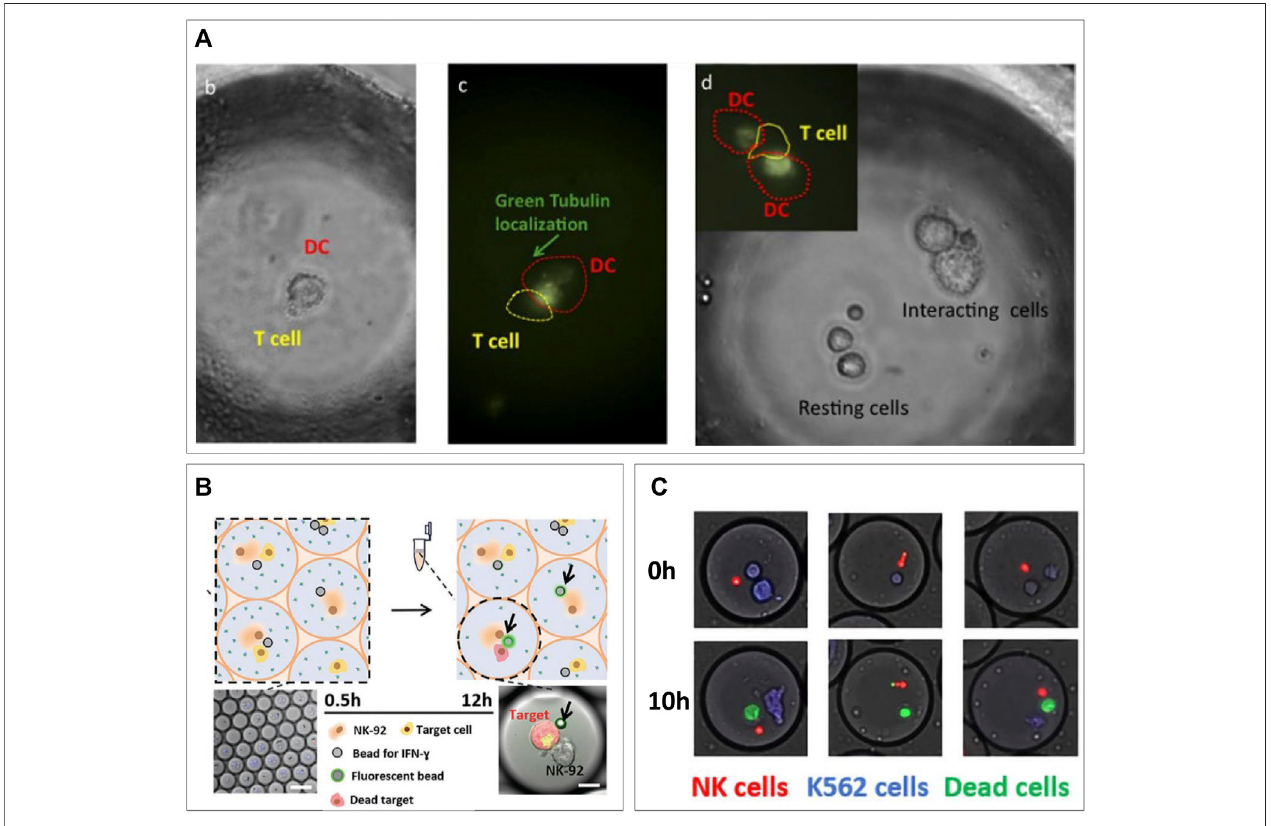
FIGURE 5 | Cell – cell pairing for single-cell immune interactions. (A) Microscopic visualization of DC/T-cell interactions. Tubulin localization indicates presence of immunesynapsespresentatdifferentratiosofcells(Konryetal.,2013). (B) MonitoringofIFN- γ secretionduringNK/tumorcellskillinginteraction(Antonaetal.,2020). (C) Primary NK cells killing tumor cells in droplets (Subedi et al.,